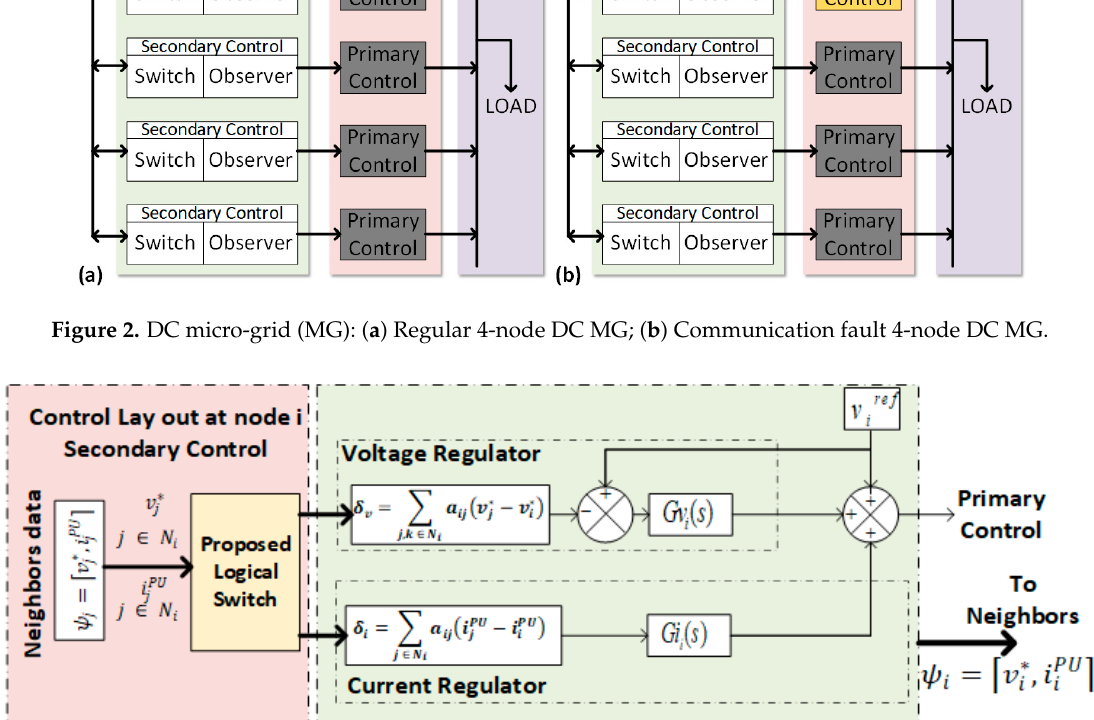
Figure 3. Proposed secondary control for a DC microgrid.